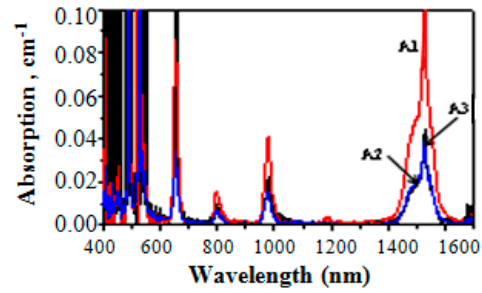
Figure 13. EPMA for Al 2 O 3 of three fibers: A1, A2, and A3.